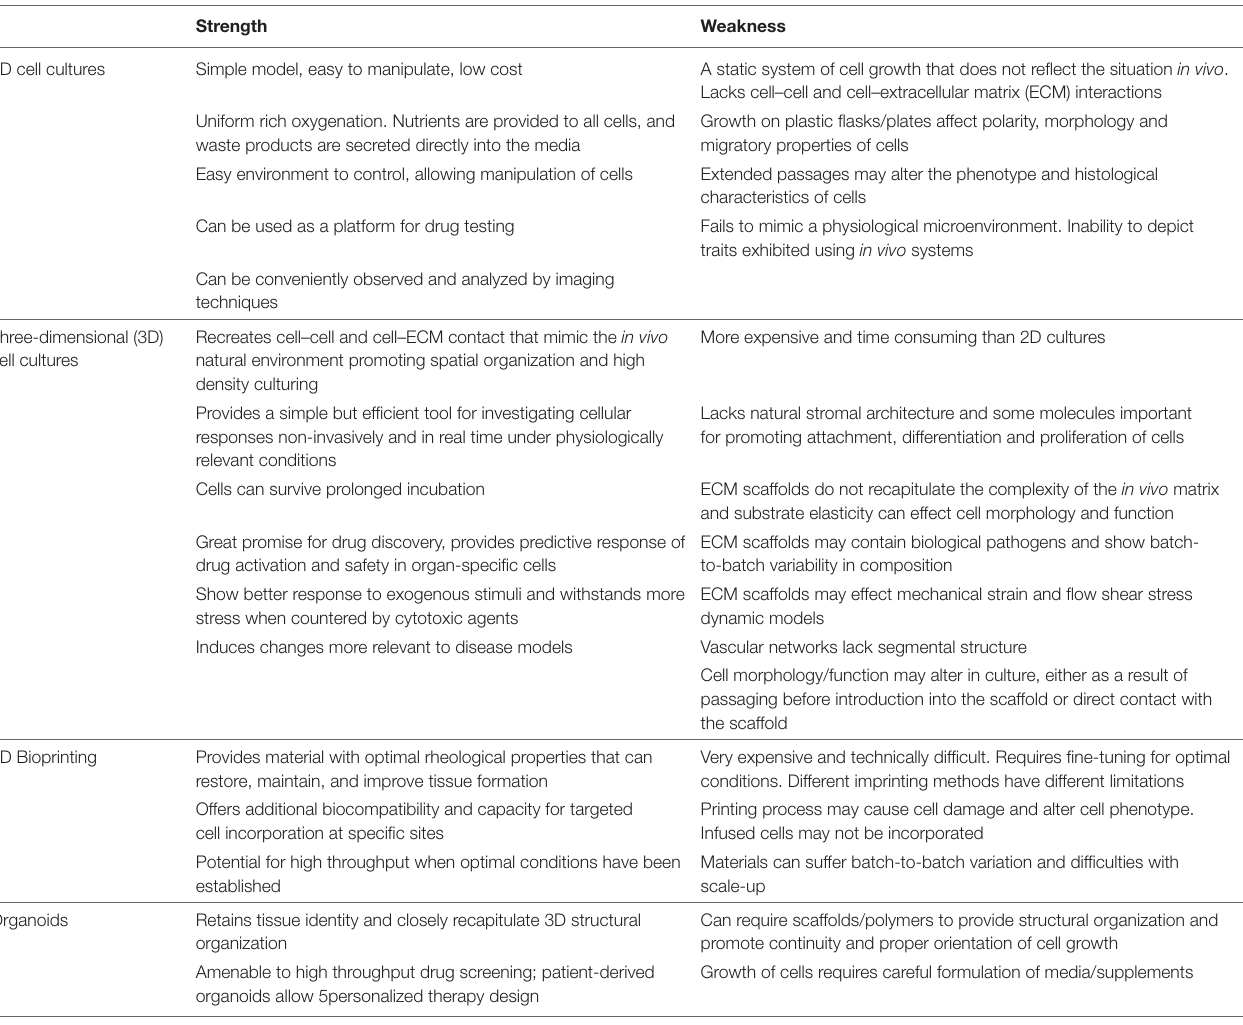
TABLe 2 | Summary of the strength and weakness of the human organ culture (HOC) with emerging cell cultures. Strength